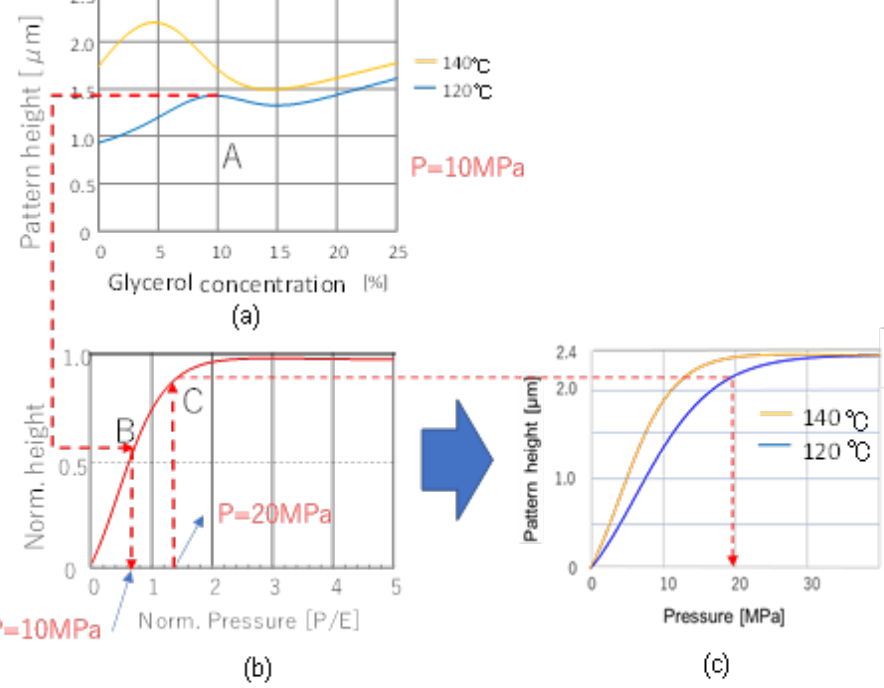
Figure 7. Diagram of the procedure for prediction by hybrid learning system. ( a ) Decide Glycerol concentration for example 10% and check pattern height, ( b ) Look normalized pattern height and find corresponded normalized pressure (in this case, it is equivalent to 10MPa), ( c ) Draw transformed relation between applied pressure versus pattern height after nanoimprinting based on ( b ).